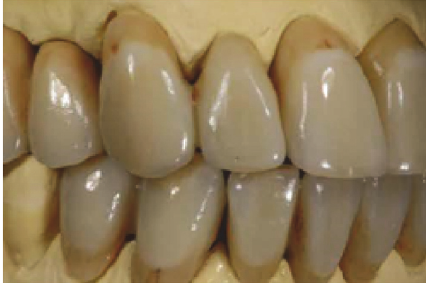
Figure 18: Final restorations, lateral right view.